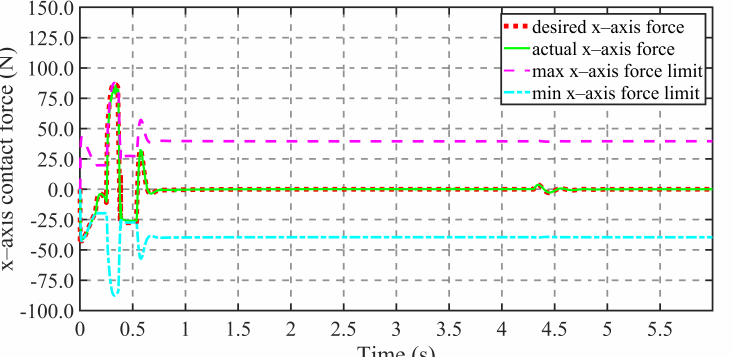
Figure 18. Horizontal contact force when the robot is sliding on terrain with a variable friction